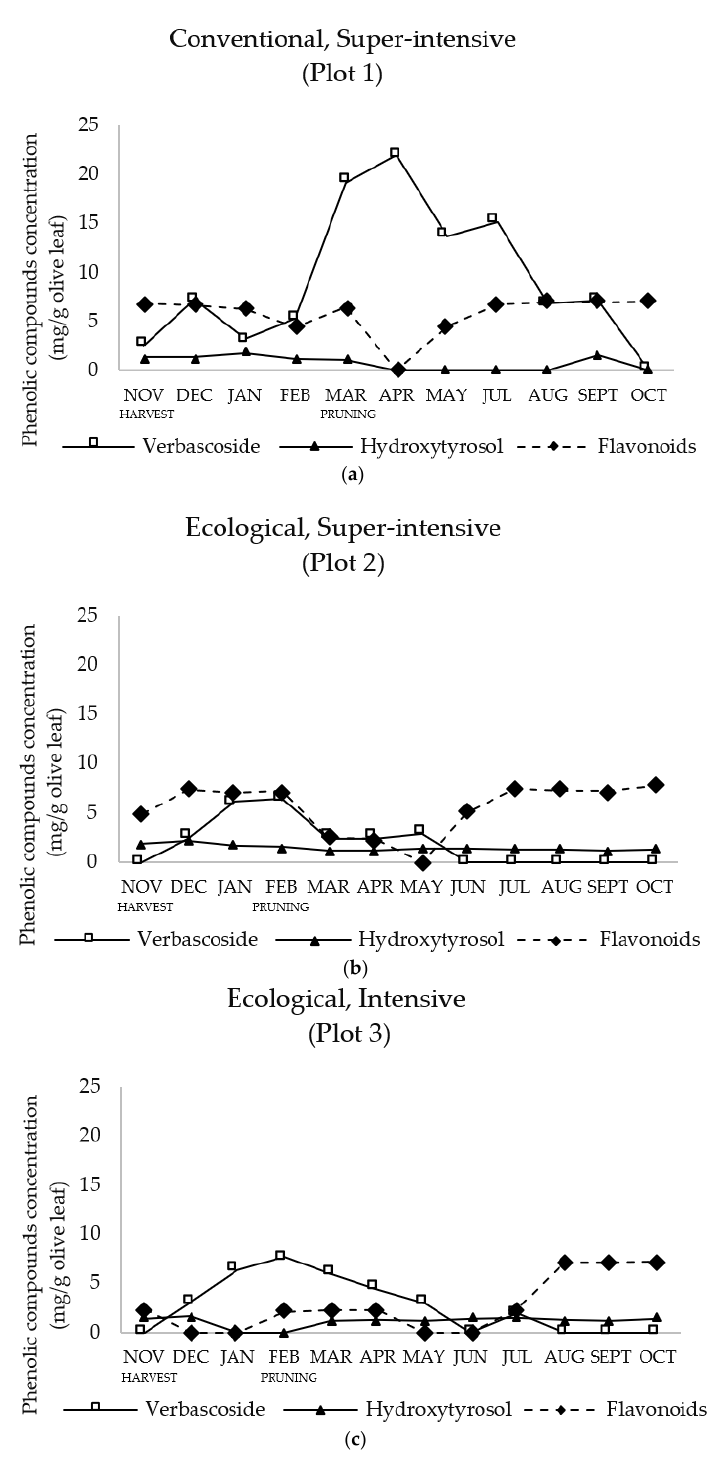
Figure 3. Evolution of several phenolic compounds (mg/g) of olive leaves cv. Arbequina during an agronomic cycle (November 2019 to October 2020). ( a ) Plot 1: Conventional and super-intensive; ( b ) Plot 2: Ecological and super-intensive; ( c ) Plot 3: Ecological and intensive.